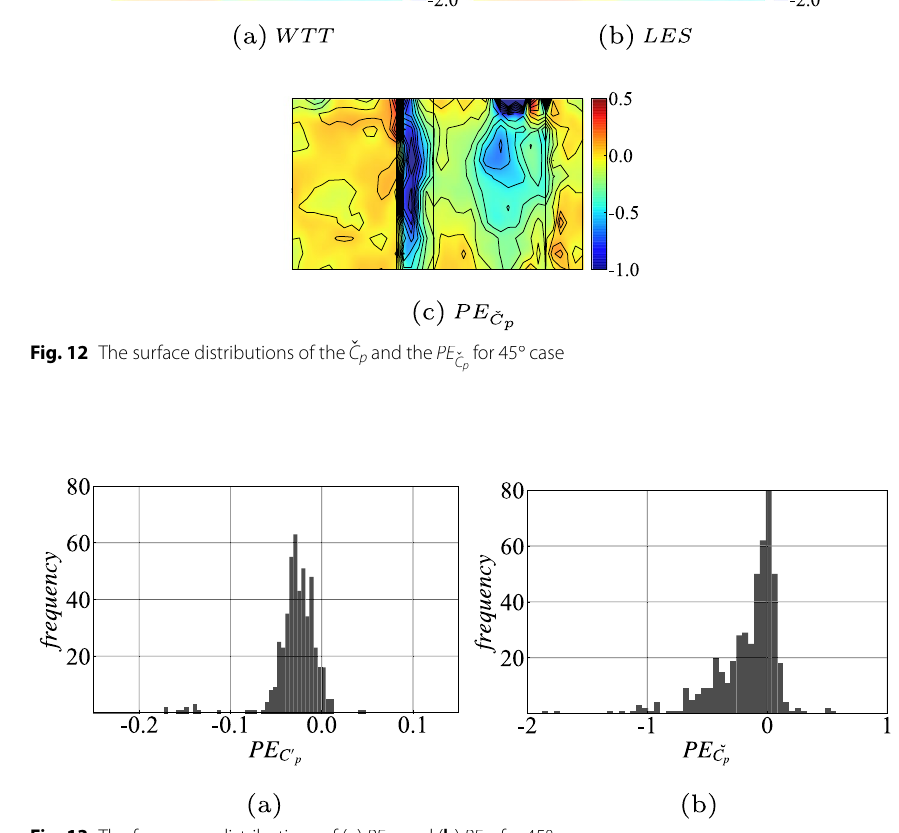
and ( b ) PE ˇ for 45 ◦ C p p